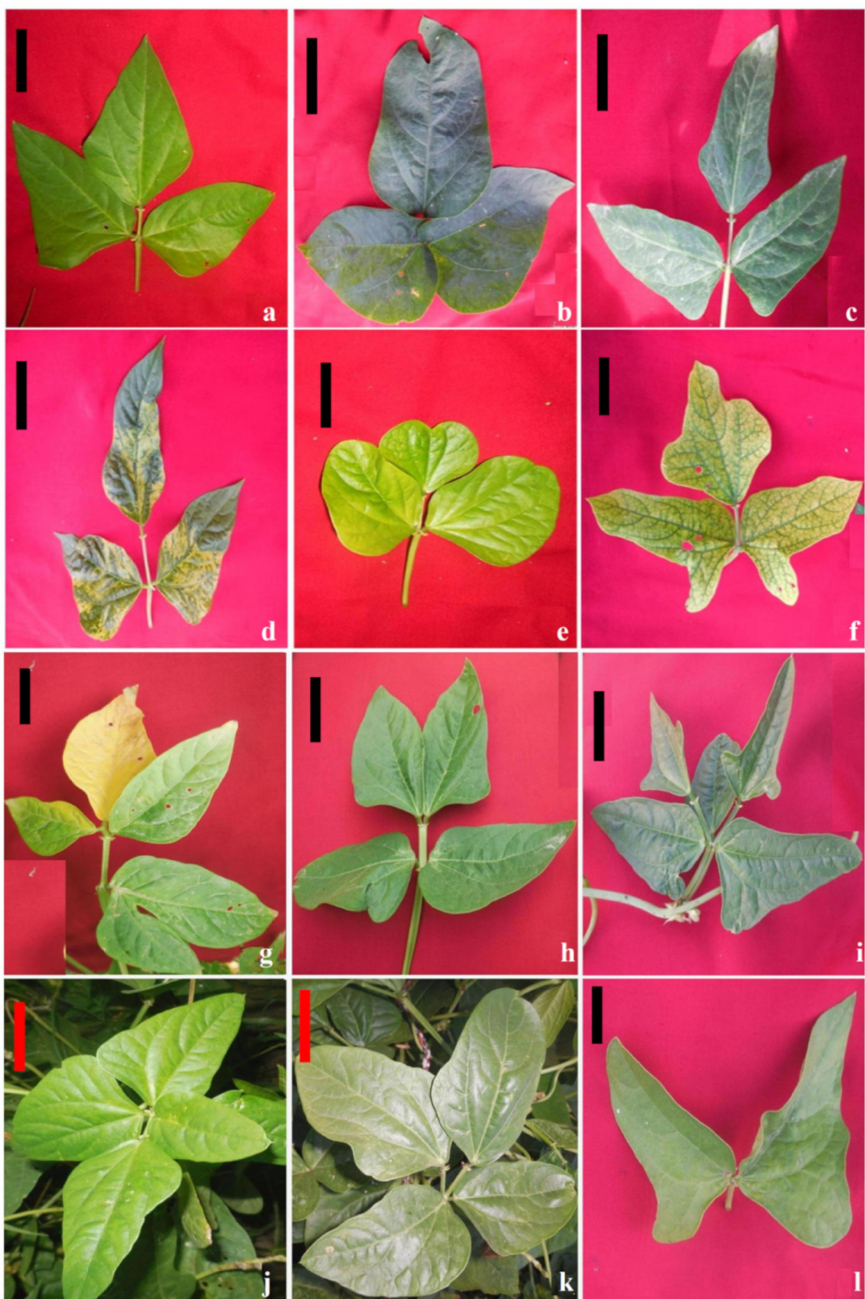
Figure 7. Representative photographs of gamma rays and sodium azide-induced alterations in leaf shape. ( a ) Control leaf, ( b ) broad-leaved mutant, ( c ) narrow-leaved mutant, ( d ) elongated rachis mutant, ( e ) altered leaf architecture with notched leaf tips, ( f ) altered leaf architecture with leaflet outgrowths, ( g ) mutant showing fused leaflets, ( h ) tetrafoliate with fused terminal leaflets, ( i ) pentafoliate mutant, ( j ) tetrafoliate with narrow leaflets, ( k ) tetrafoliate with broad leaflets, and ( l ) bifoliate mutant. Scale Bar = 2